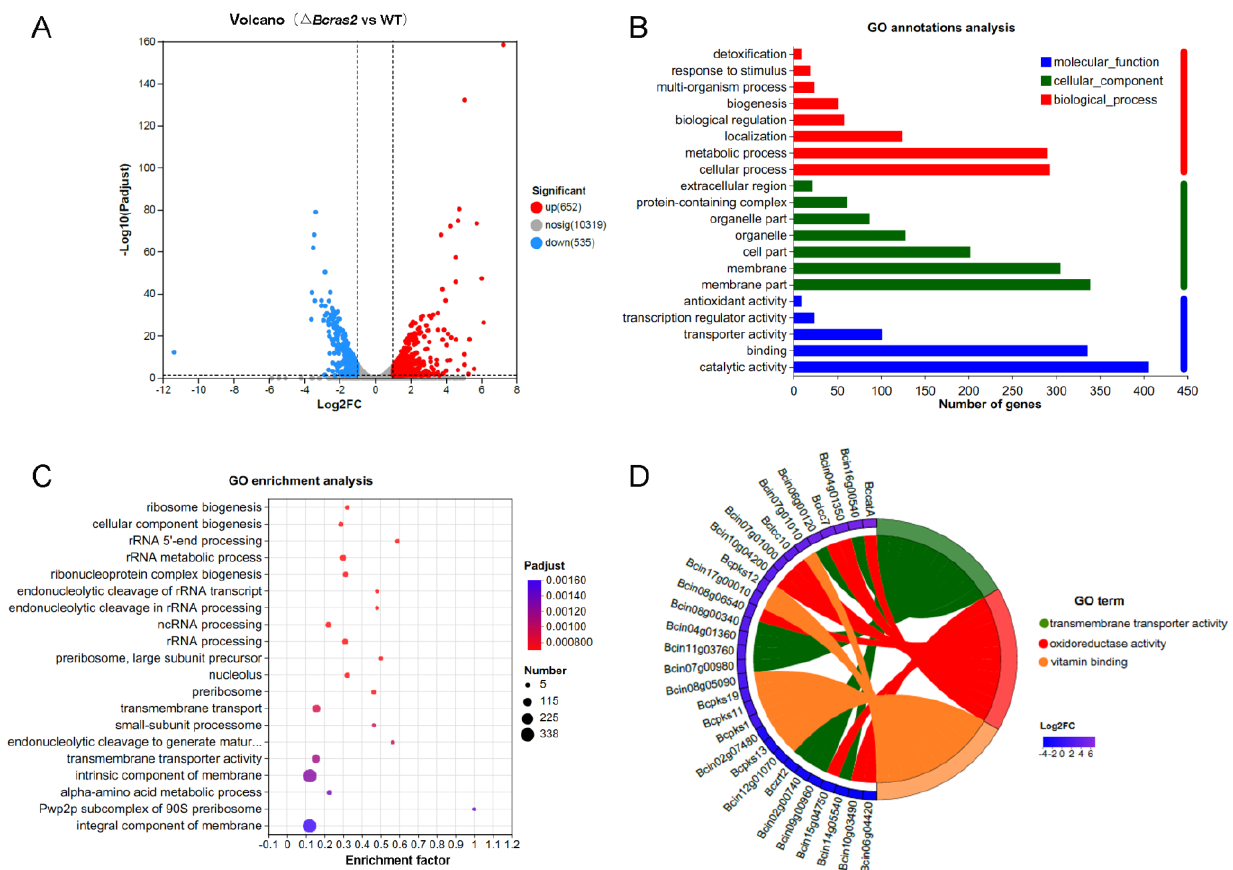
Figure 5. Analysis of differentially expressed genes in ∆ Bcras2 mutants: ( A ) volcano plot of the downstream genes. ( B ) GO annotation analysis of the differentially expressed downstream genes. ( C ) GO enrichment of the genes by Bubble Chart. ( D ) Enrichment Chord for top 10 differentially expressed genes in the first 3 highly enriched GO terms. Benjamini-Hochberg (BH) multiple testing correction was used for the adjusted p -values.